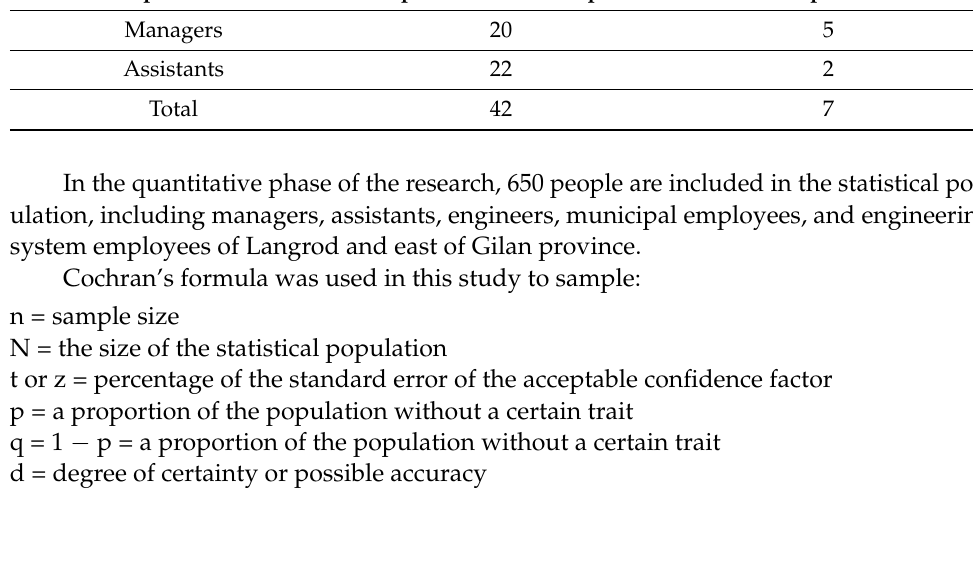
Table 1. Frequency of qualitative statistical population (semi-structured interview).